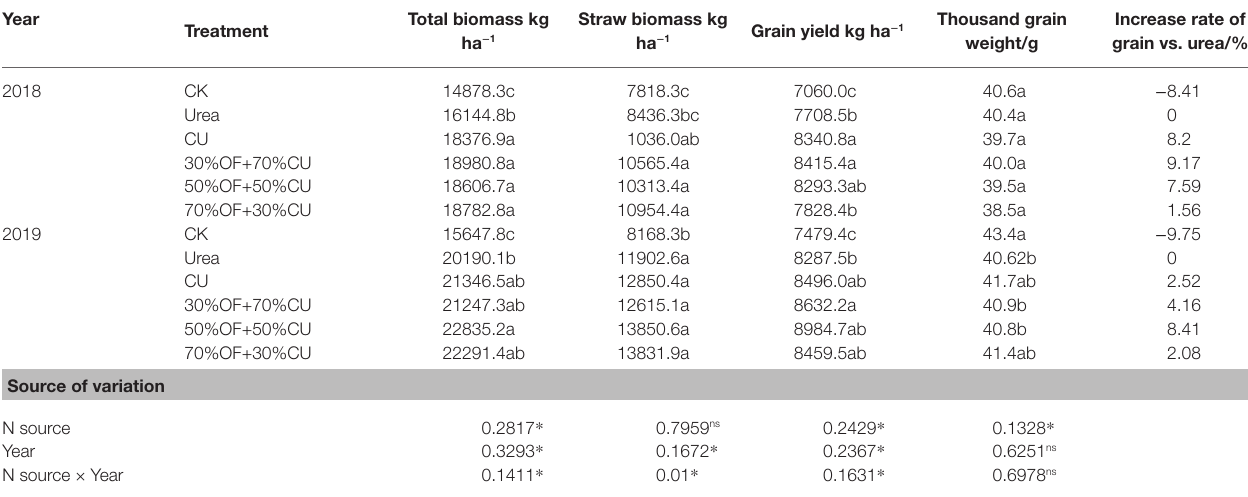
TABLE 1 | Grain yields and straw biomass of wheat under different N application